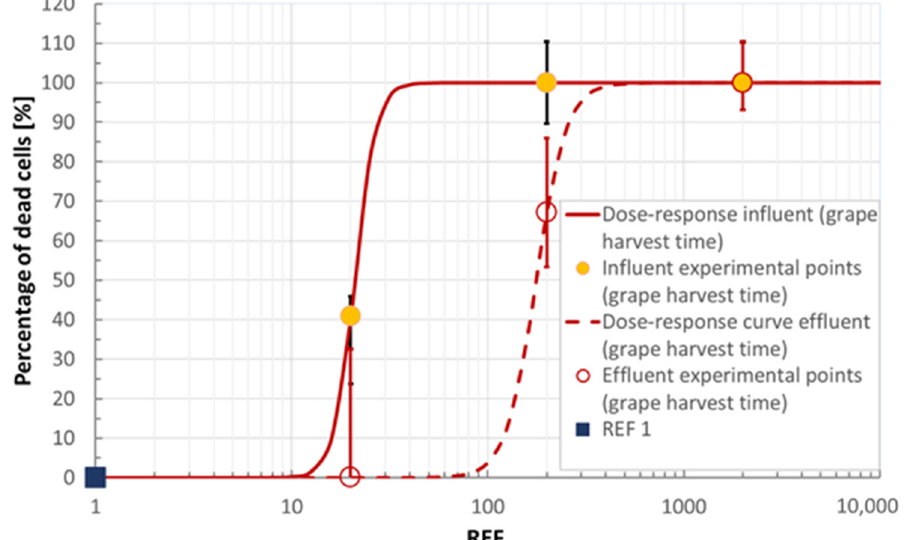
Figure 5. Cell viability in IAR203 hepatic cells exposed to different concentrations of influent and effluent wastewaters (first campaign). Values are expressed as % versus the untreated control. Cell viability was assessed with Neutral Red Assay in triplicate: error bars show maximum and minimum values.